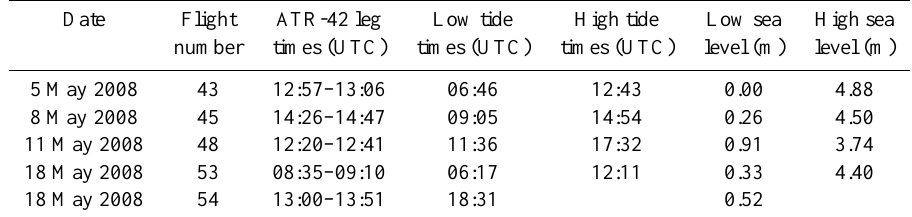
Table 2. Tide conditions during the Group I and Group III events observed during five